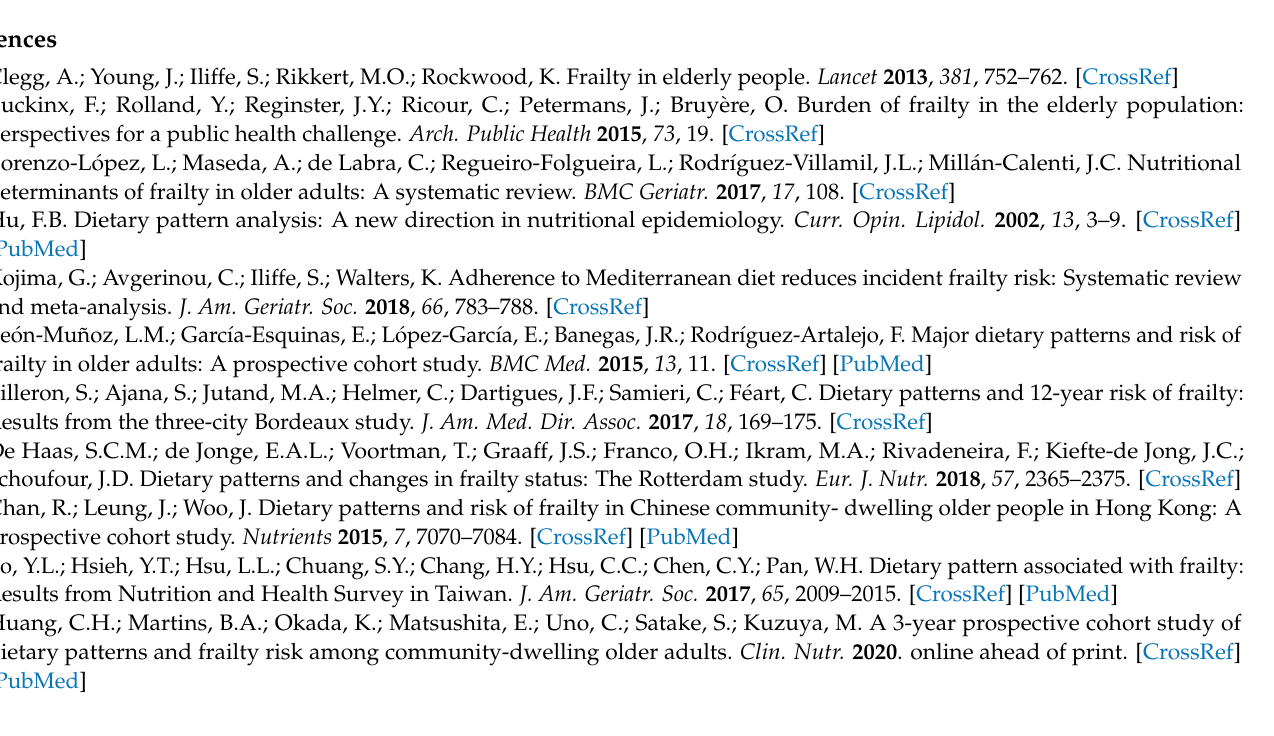
Table S1: Macronutrient intake by tertiles of food